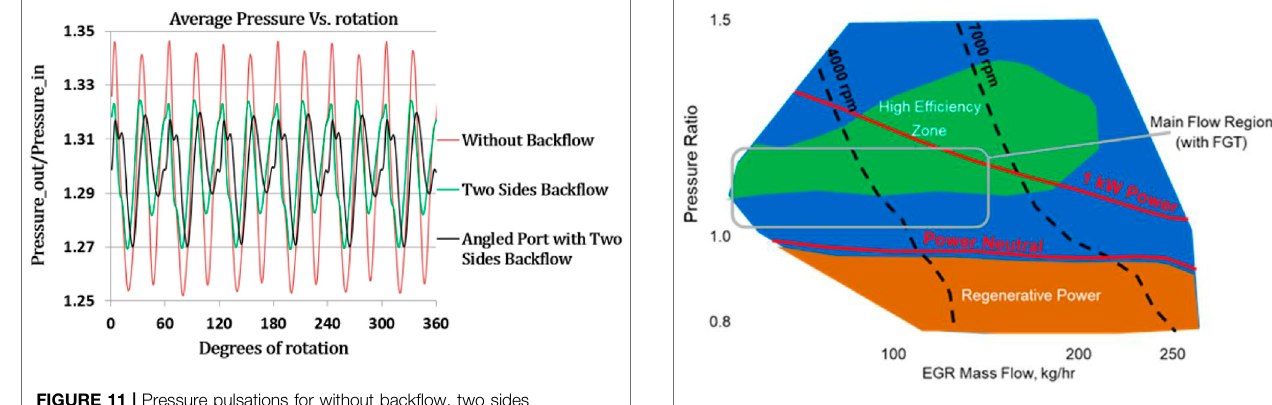
FIGURE 13 | EGR pump performance map (Bitsis et al.,